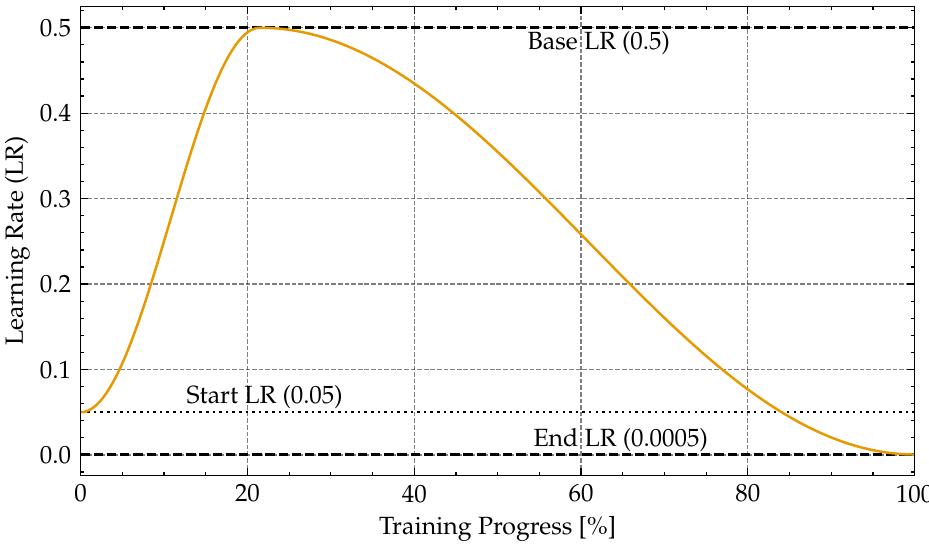
Figure A2. Detailed learning rate schedule throughout the training